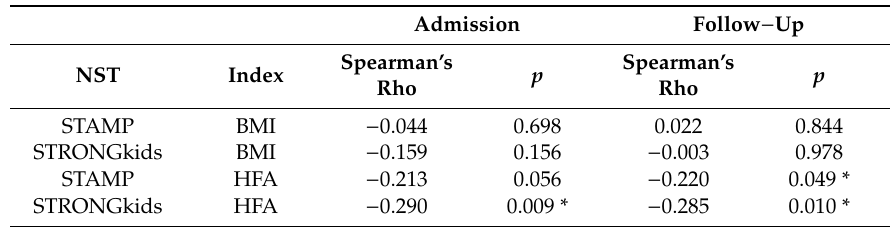
Table 2. Correlations between STAMP and STRONGkids tools and body mass index (BMI) and height for age (HFA) z scores.